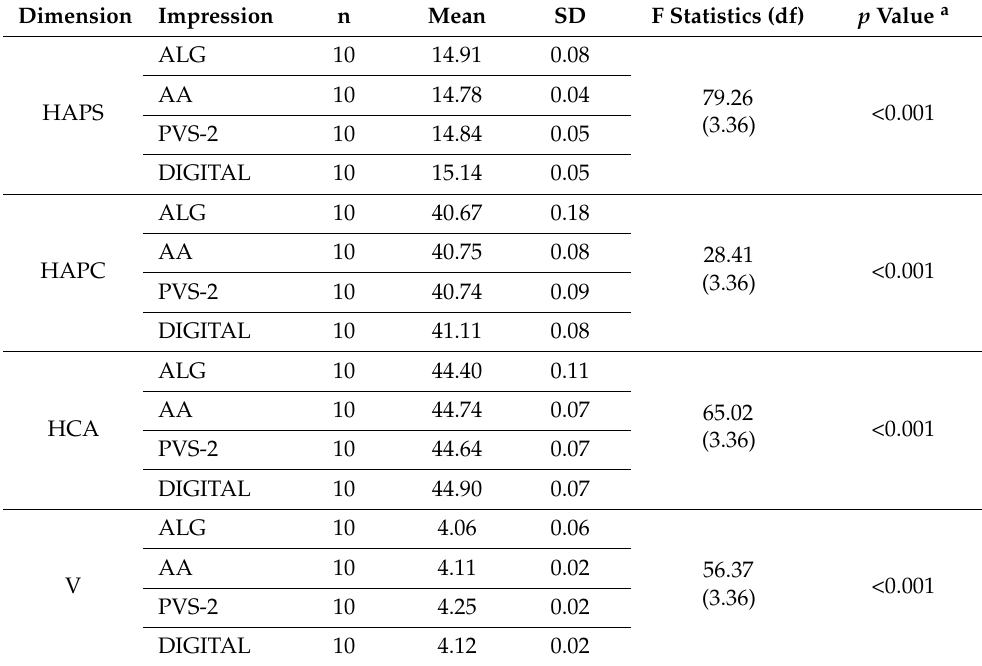
Table 3. Comparison of dimensional accuracy (mm) between ALG, AA, PVS-2 generated casts and digitally printed models using a one-way ANOVA. Dimension